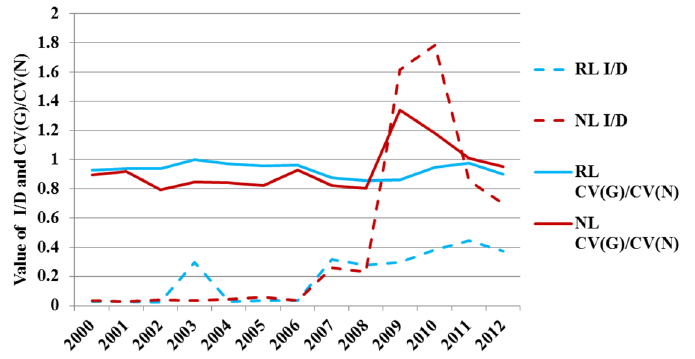
Figure 7. Dominance of indirect effects and homogenization of China’s natural gas supply system based on network models on the RL and the NL.